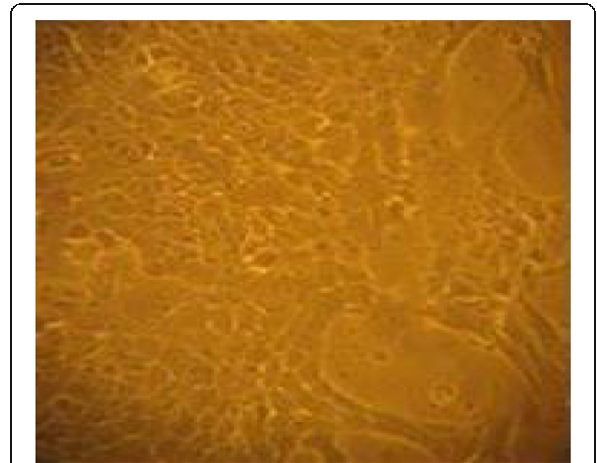
Fig. 3 Sensitivity of 4TI cancer cells to black tea at IC 50 of 44.04 μ g/ml showing disruption of monolayer